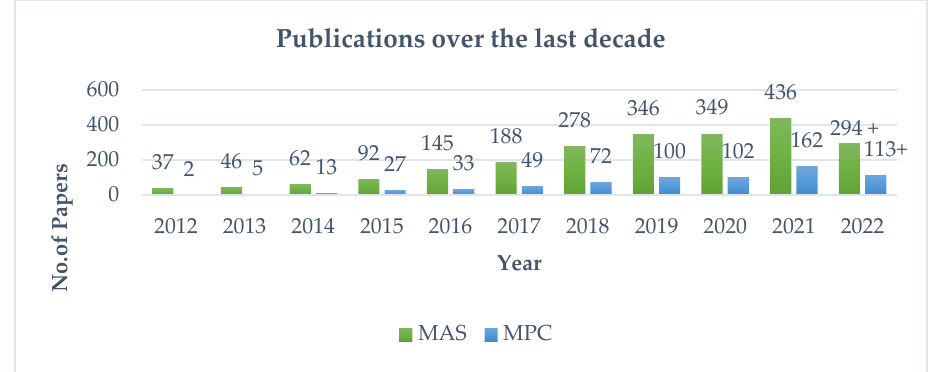
Figure 3. Papers published with keywords related to MG control using MAS and MPC methods.